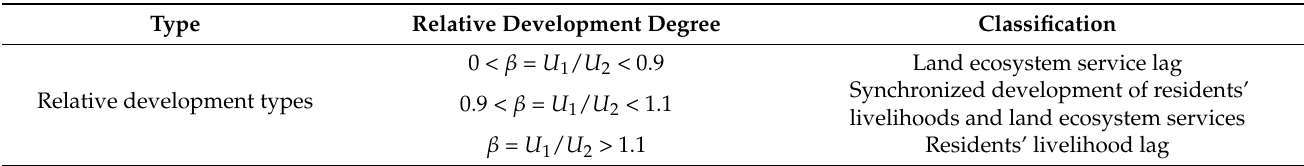
Table 6. Classification standard for relative development